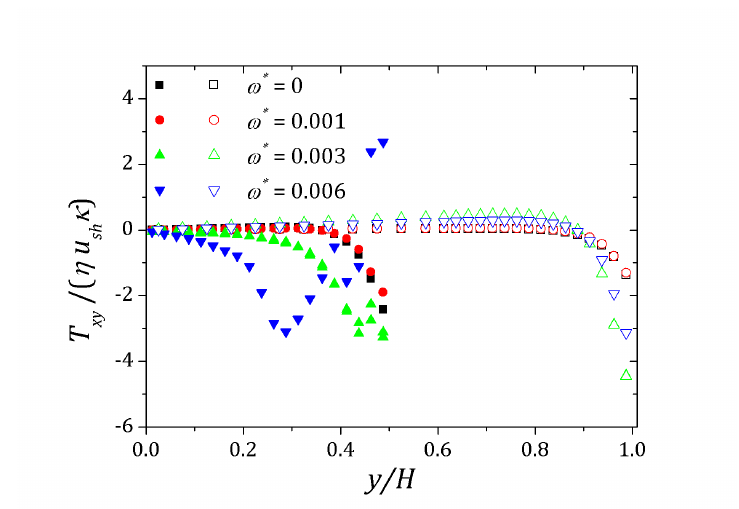
Figure 26. Shear stress into the contraction and right after the expansion of the channel. Results for De κ = 2.5, ε = 0.1 and perturbation parameter ω ∗ = 0, 1.0 × 10 − 3 , 3.0 × 10 − 3 and 6.0 × 10 − 3